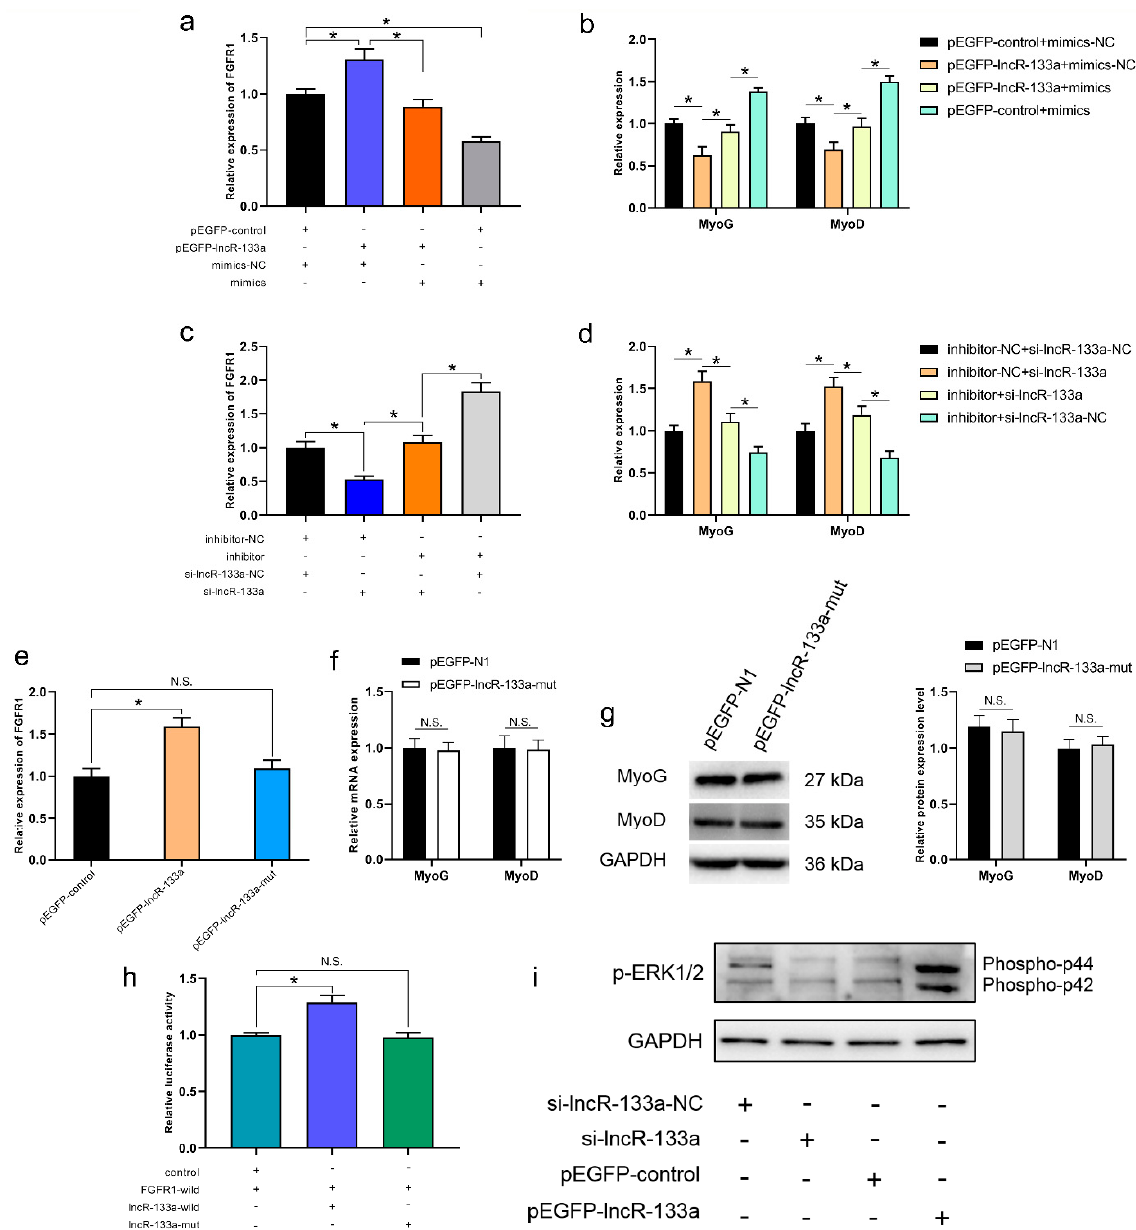
Figure 6. LncR-133a regulates FGFR1 expression and MuSCs differentiation via miR-133a-3p and promotes the phosphorylation of ERK1/2. ( a ) The expression of FGFR1 was determined after treat- ment with pEGFP-lncR-133a and/or miR-133a-3p mimics. ( b ) The expression of MyoG and MyoD were detected after treatment with pEGFP-lncR-133a and/or miR-133a-3p mimics. ( c ) The expres- sion of FGFR1 was measured after treatment with miR-133a-3p inhibitor and/or si-lncR-133a. ( d ) The expression of MyoG and MyoD were detected after treatment with si-lncR-133a and/or miR- 133a-3p inhibitor. ( e ) The expression level of FGFR1 in MuSCs transfected with pEGFP-lncR-133a